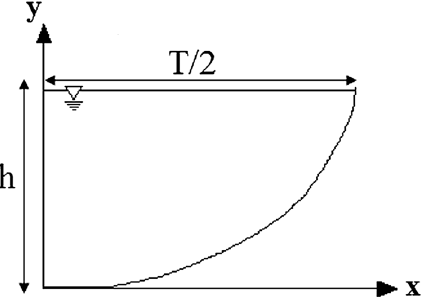
Fig. 1 Geometry definition sketch of bank profile in stable